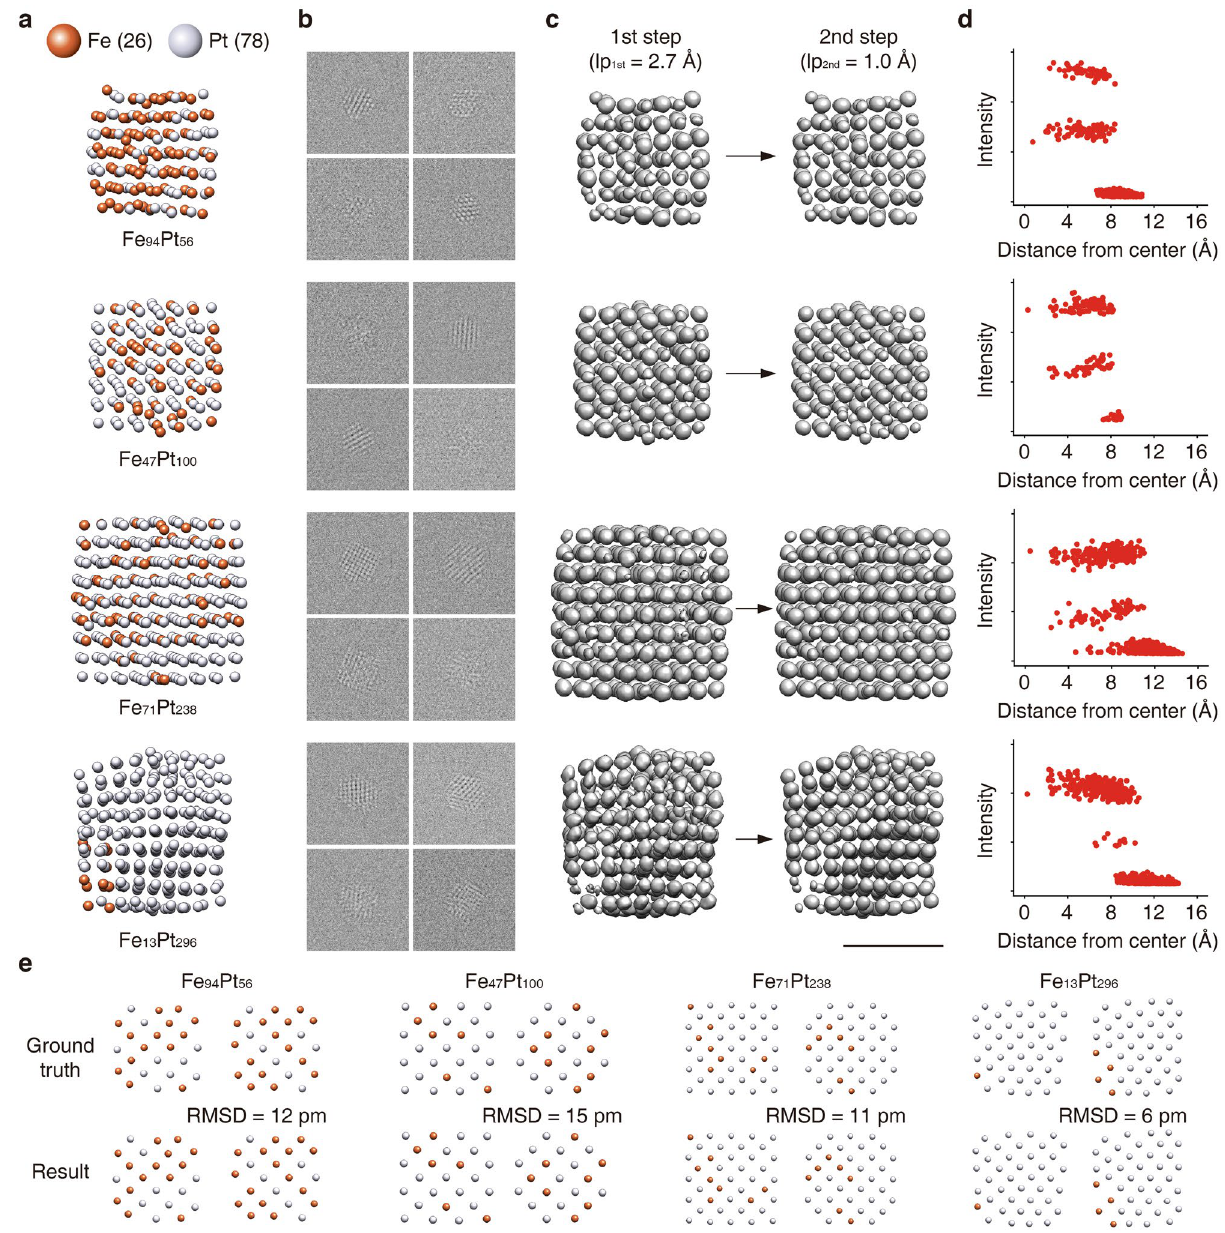
Figure 4. 3D reconstruction process for disordered multi-element nanoparticles. ( a ) Input atomic structures. Grey and orange spheres correspond to Pt and Fe atoms, respectively. Ground truth structures are geometrically optimized by DFT calculations. ( b ) Representative simulated TEM images. ( c ) 3D Coulomb density maps obtained by two-step reconstruction. ( d ) Plots of distance from center of mass as a function of local maximal intensity. ( e ) Representative slices of 3D atomic maps of ground truth structures and reconstructed structures. Root mean square displacement (RMSD) between input and reconstructed structures are depicted. Scale bar, 1